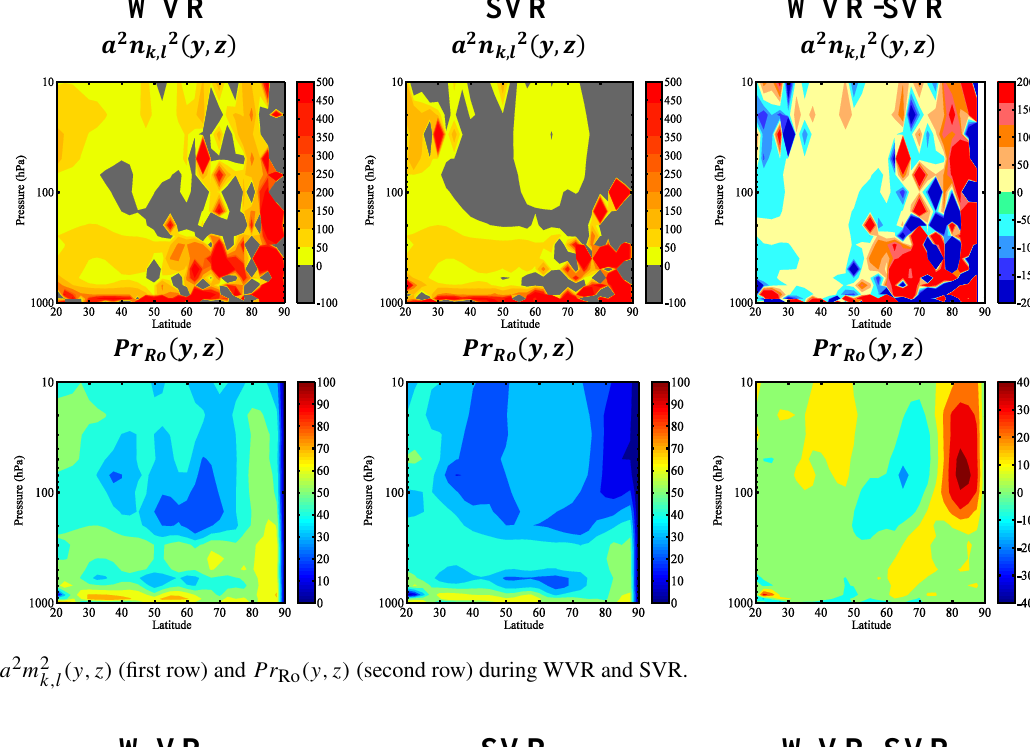
(y,z) (first row) and Pr Ro (y,z) (second row) during WVR and SVR. Figure 11. a 2 m 2 k,l